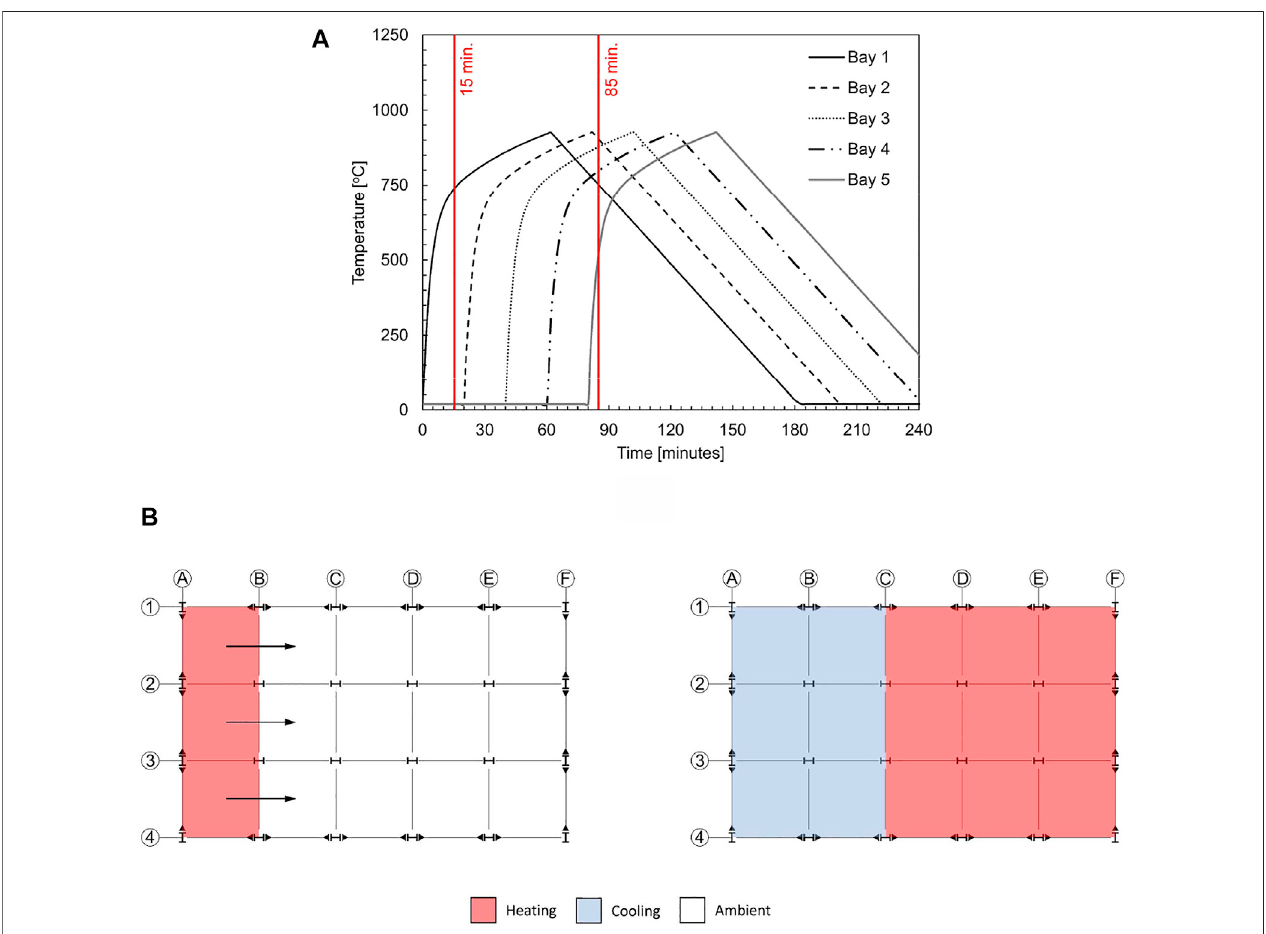
FIGURE 4 | (A) Temperature-time curves for Fire Scenario #2 and (B) gas temperature classi fi cations for Fire Scenario #2 at 15 min (left) and 85 min (right).